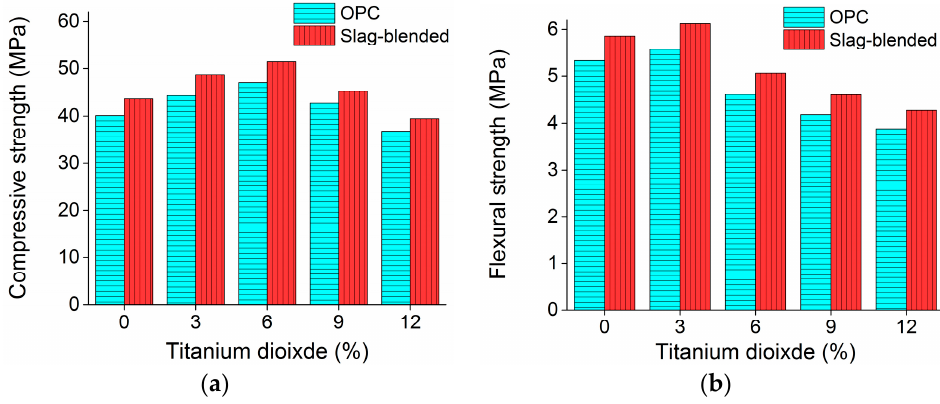
Figure 3. Variation of mechanical properties with the addition of nano-TiO 2 in mortars at the age of 28 days ( a ) compressive strength ( b ) flexural strength.